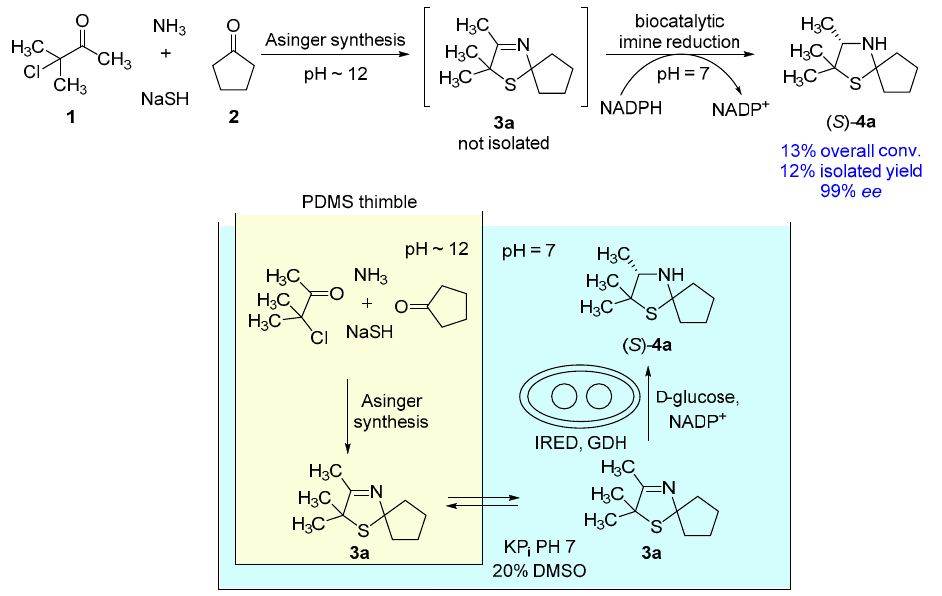
Figure 5. One ‐ pot process towards synthesis of (S) ‐ 2,2,3 ‐ trimethyl ‐ 1 ‐ thia ‐ 4 ‐ Figure 5. One-pot process towards synthesis of (S)-2,2,3-trimethyl-1-thia-4-azaspiro[4.4]nonane ( 4a azaspiro[4.4]nonane ( 4a ).